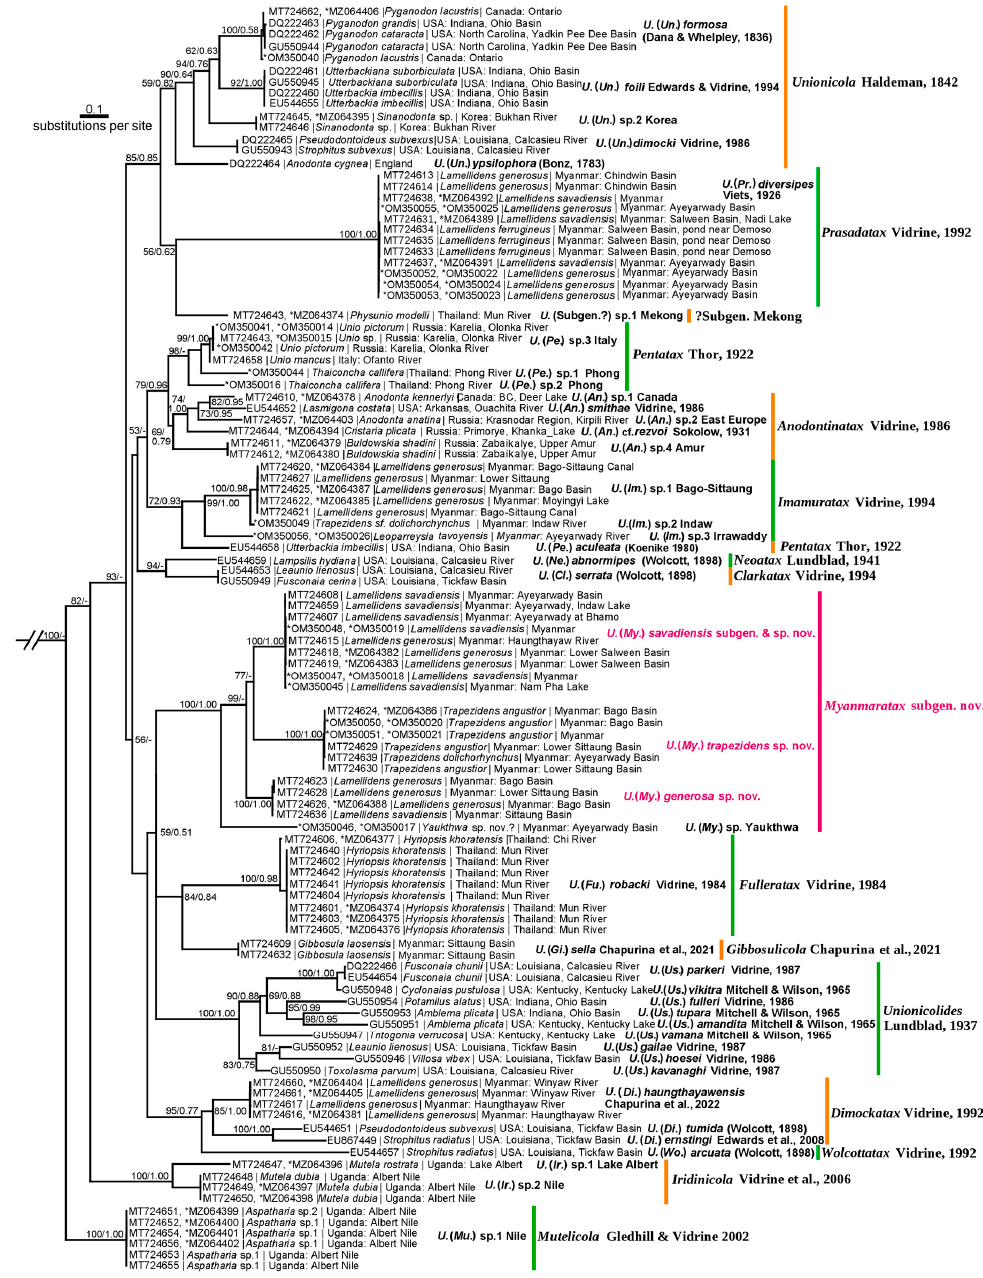
Figure 2. Two-locus maximum likelihood phylogeny of the genus Unionicola (COI + 28S). Each sequence name contains the following information: GenBank accession number | mussel host name | collecting locality. The numbers near nodes are BS/BPP values. Subgenus-level clades are highlighted by different line colors. The new taxonomic names are in red. New sequences generated in this study are marked with an asterisk. Outgroup is not